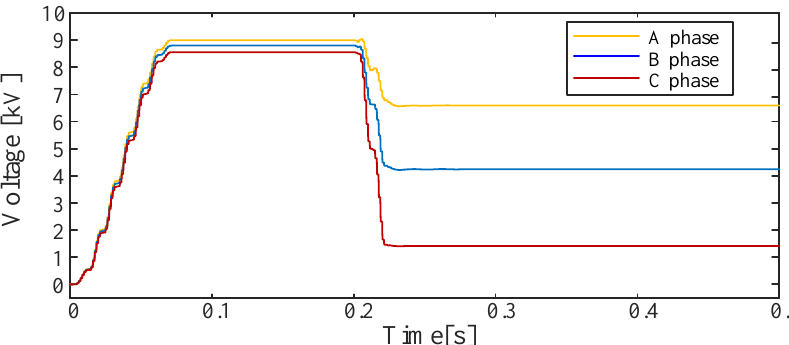
Figure 11. Current amplitude of a two-phase short-circuit fault on line CD.